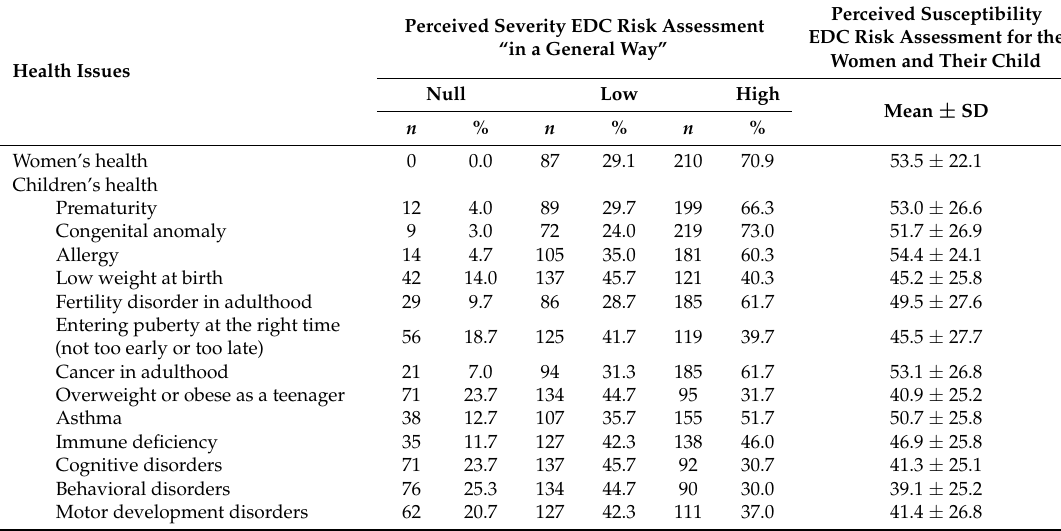
Table 3. EDC risk assessment towards health